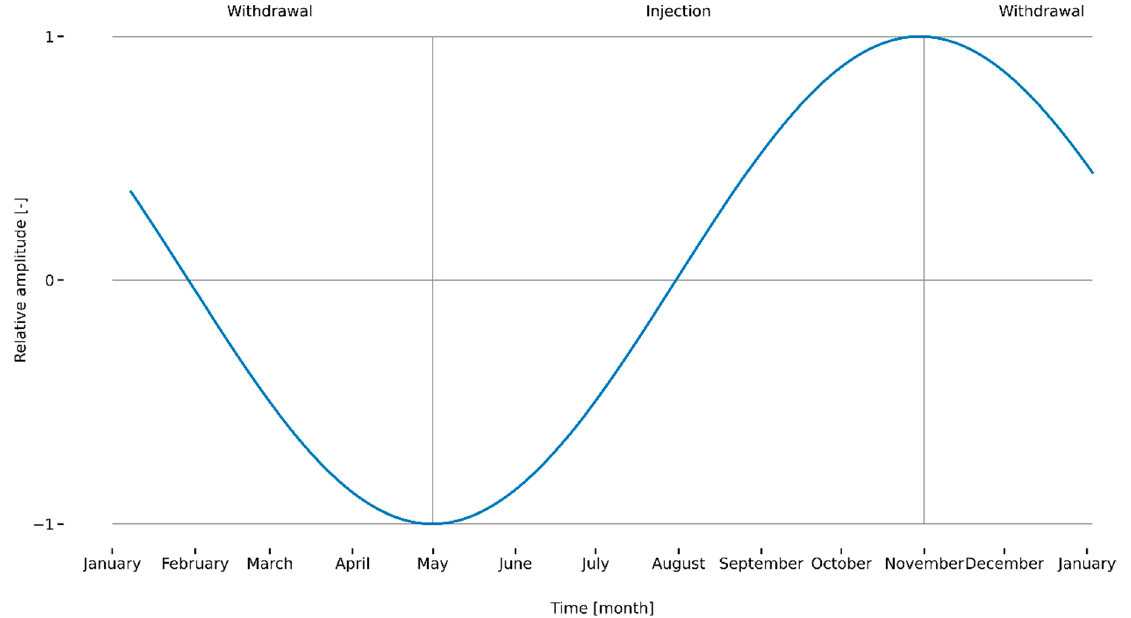
Figure 3. The theoretical course of injection and withdrawal cycle at UGS (adopted by [22]).